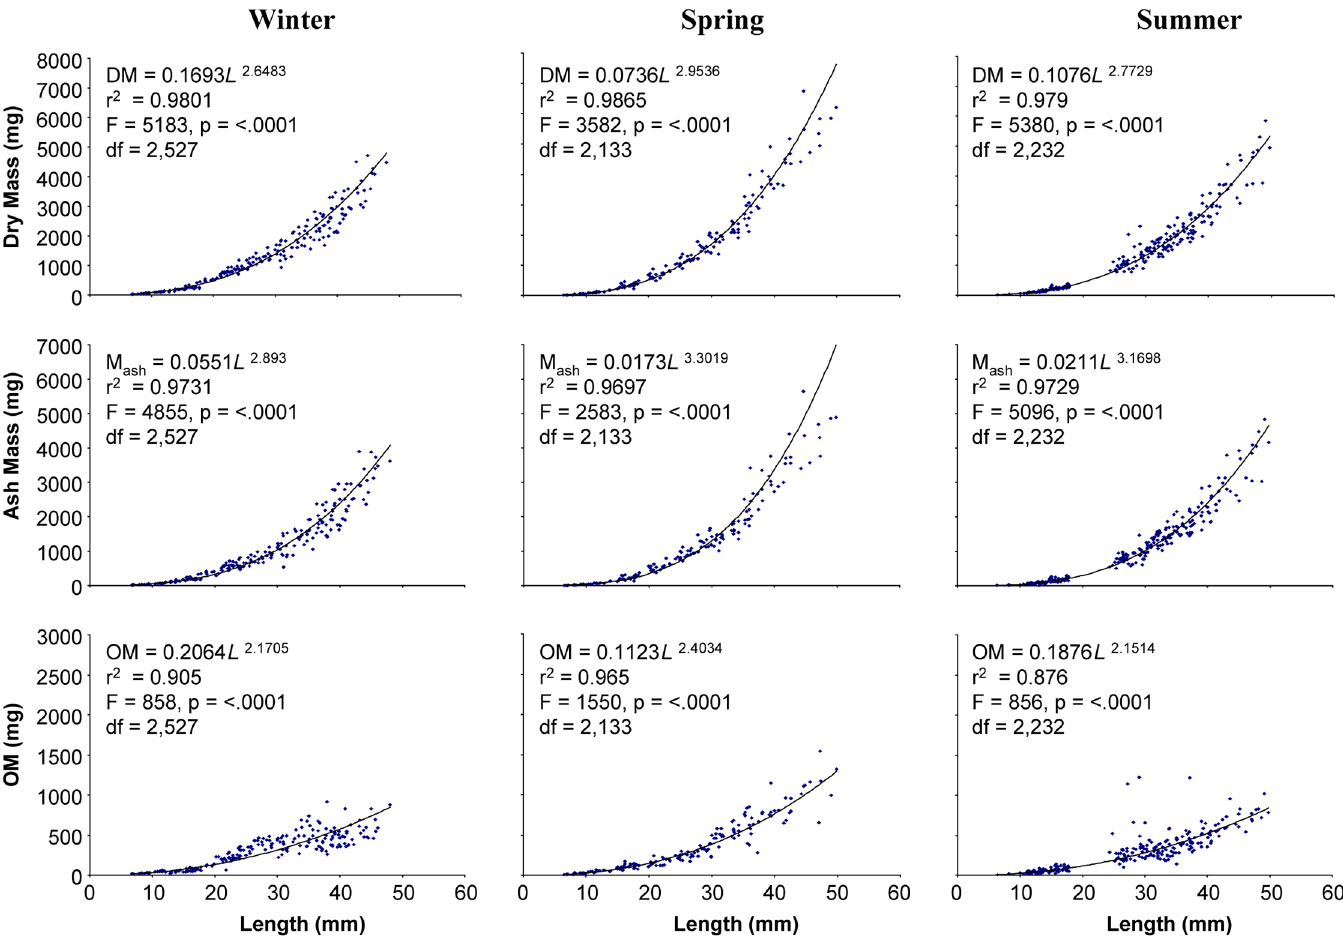
Fig 2. Dry, ash, and organic matter masses of Ischadium recurvum collected seasonally relative to shell length. Dry mass (DM; mg), ash mass (M ash ; mg), and organic matter (OM; mg) of Ischadium recurvum (including shell) as a function of length (mm) collected from the Chesapeake Bay in winter, spring, and summer. All regressions were significant at the 5% level (p <